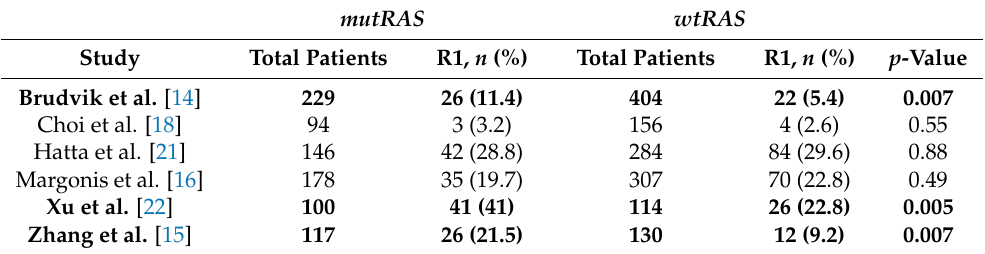
Table 3. Margin positivity (R1) depending on RAS mutational status.